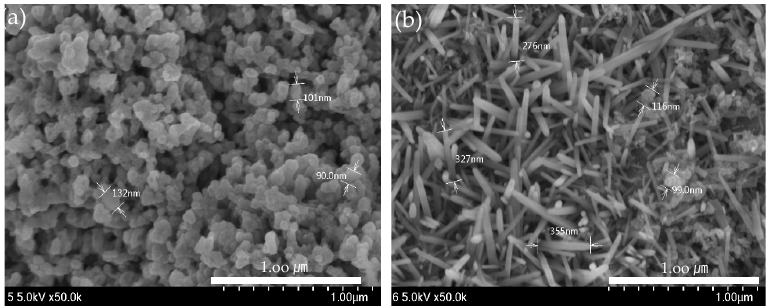
Figure 5. ZnO surface (50,000 J) observed by FE-SEM ( a ) 50,000 J ( b ) 200,000 J.